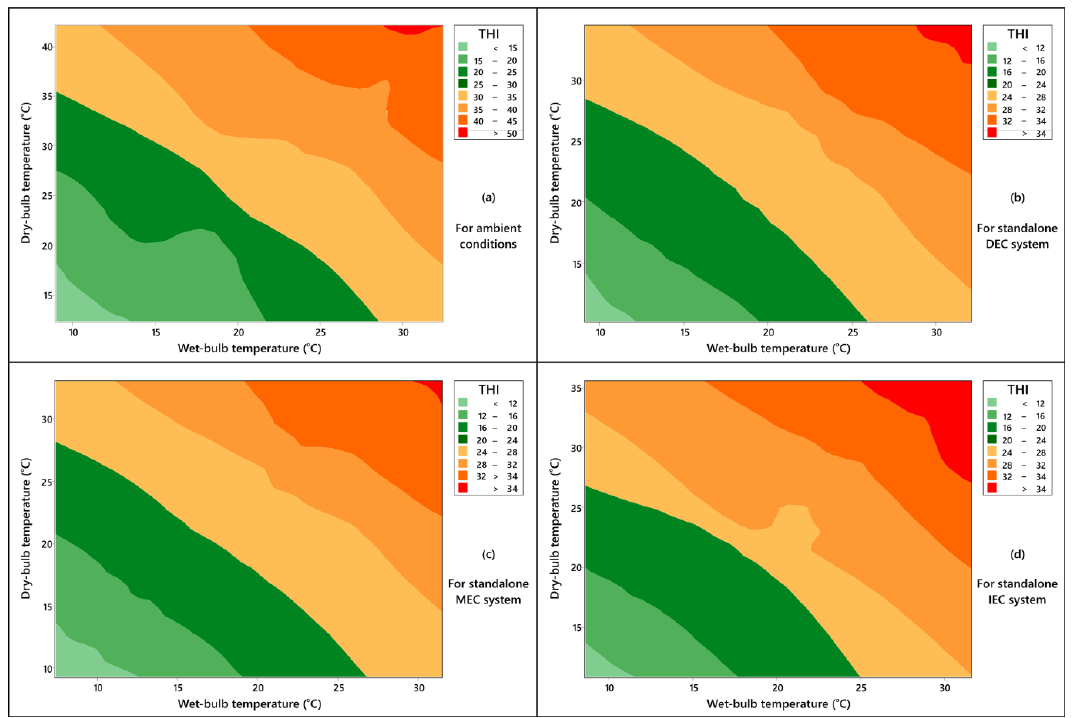
Figure A1. Impact of T db and T wb on THI for the EC systems represented on contour plots.